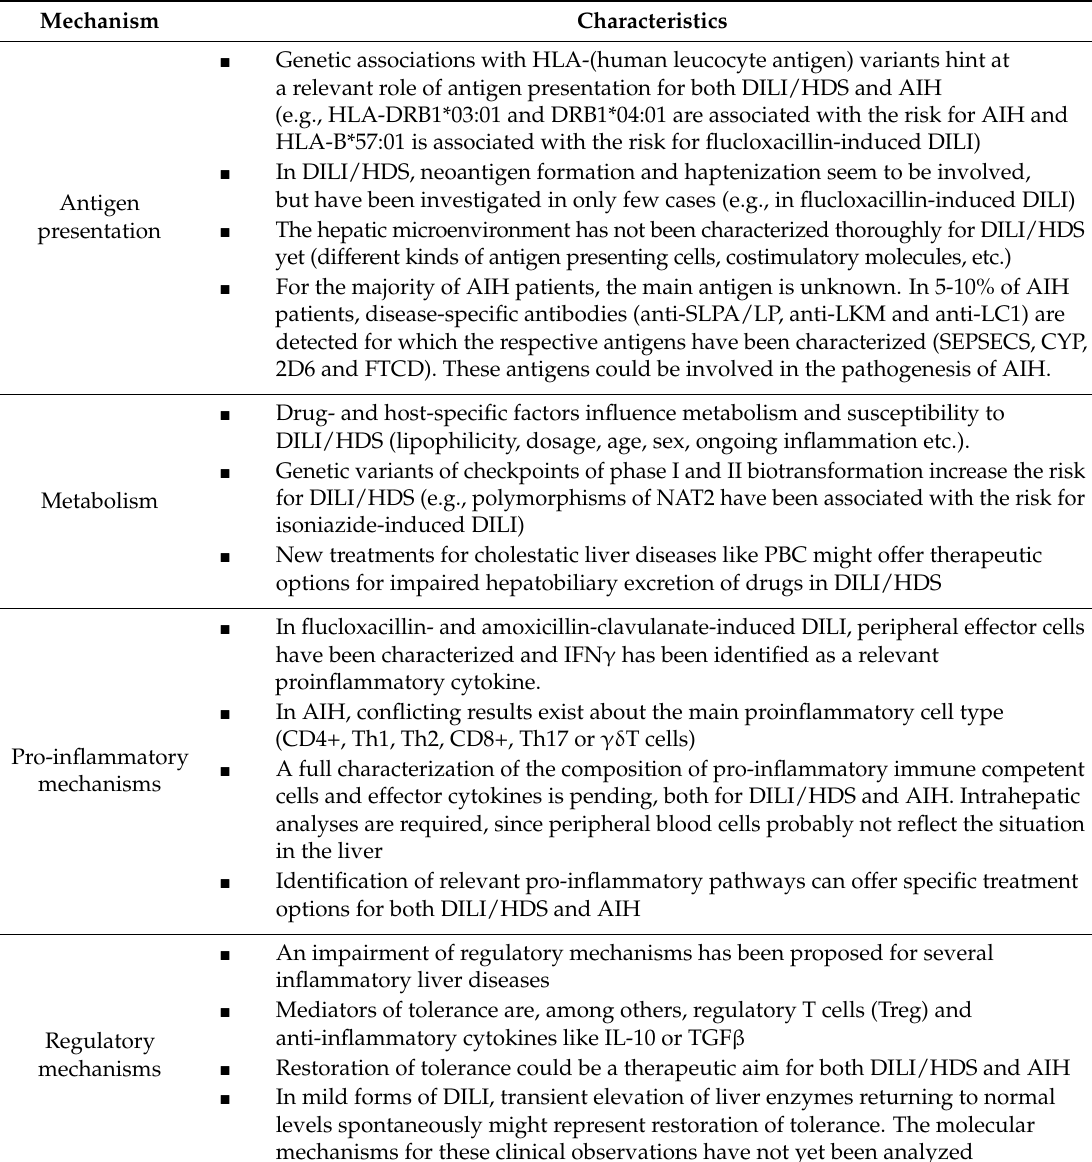
Table 2. Molecular mechanisms of DILI/HDS and